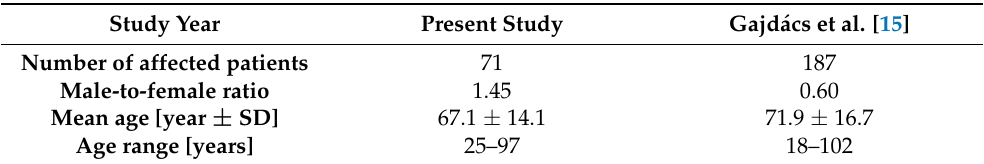
Table 2. Demographic characteristics of patients affected by anaerobic bacteremia in the present study and in our previous comparator